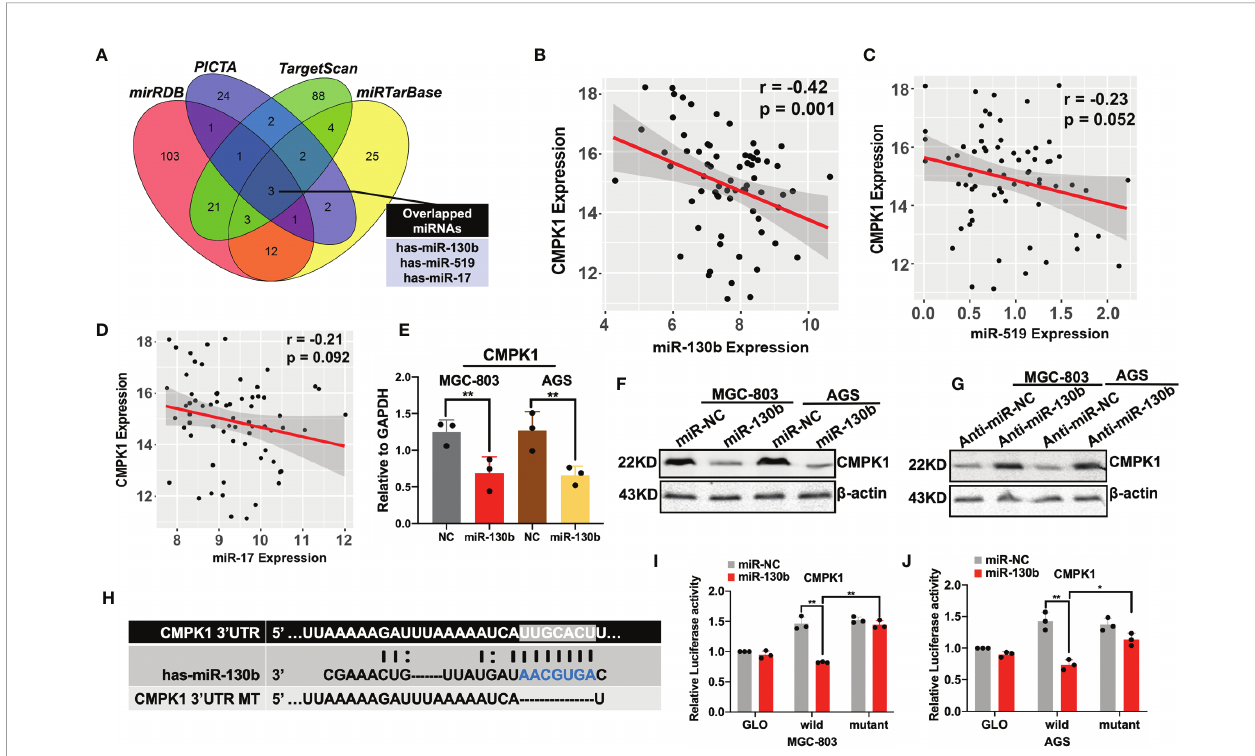
FIGURE 3 | Prediction and validation of CMPK1 upstream regulator miR-130b in gastric cancer. (A) A Venn diagram showing the combination of four miRNA prediction algorithms identi fi ed three candidate upstream regulators of CMPK1. (B – D) Inverse correlation between CMPK1 and miR-130b, miR-519, and miR-17 in GC tissue (E) RT-qPCR analysis revealed that transfection with miR-130b mimic decreased the CMPK1 RNA level. (F) The protein level of CMPK1 was decreased in MGC-803 and AGS cells when transfected with miR-130b with b -actin as a loading control. (G) On the contrary, cells transfected with anti-miR-130b expressed increased levels of CMPK1 protein compared to those transfected with anti-miR-NC. (H) A putative miR-130b -binding site exists in the 3 ′ -UTR of the CMPK1 mRNA, and 7-nucleotide deletion were generated in the binding site. (I) MGC-803 and (J) AGS cells transfected with pmirGLO-CMPK1-Wild and pmirGLO-CMPK1- Mut reporters, together with a miR-130b mimic or negative control, miR-130b overexpression suppressed the activity of luciferase in the wild-type but not in mutant type. All the values shown were represented as means ± SD. (*P < 0.05; **P < 0.01 vs negative control by two-tailed Student ’ s